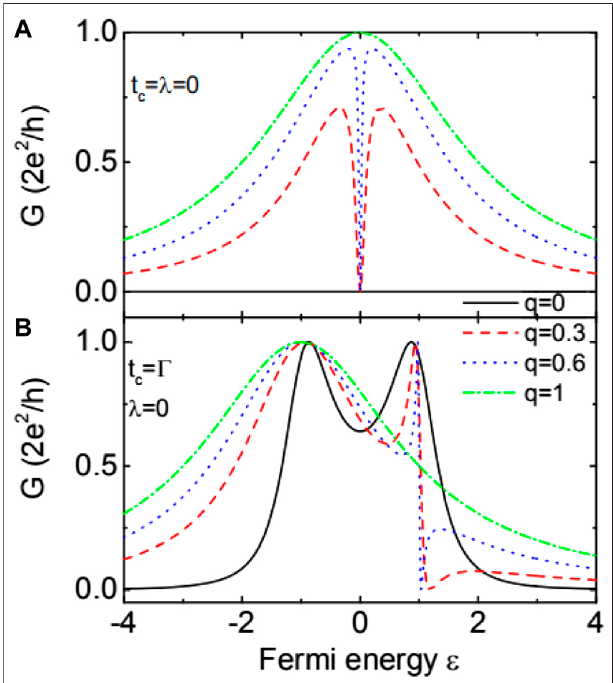
FIGURE 2 | Linear conductance varying as a function of the Fermi energyintheabsenceofQD-MBSscoupling ( λ (cid:1) 0 ) for t c (cid:1) 0in (A) ,and t c (cid:1) Γ in (B) . The con fi guration of the structure is varied by the value of q